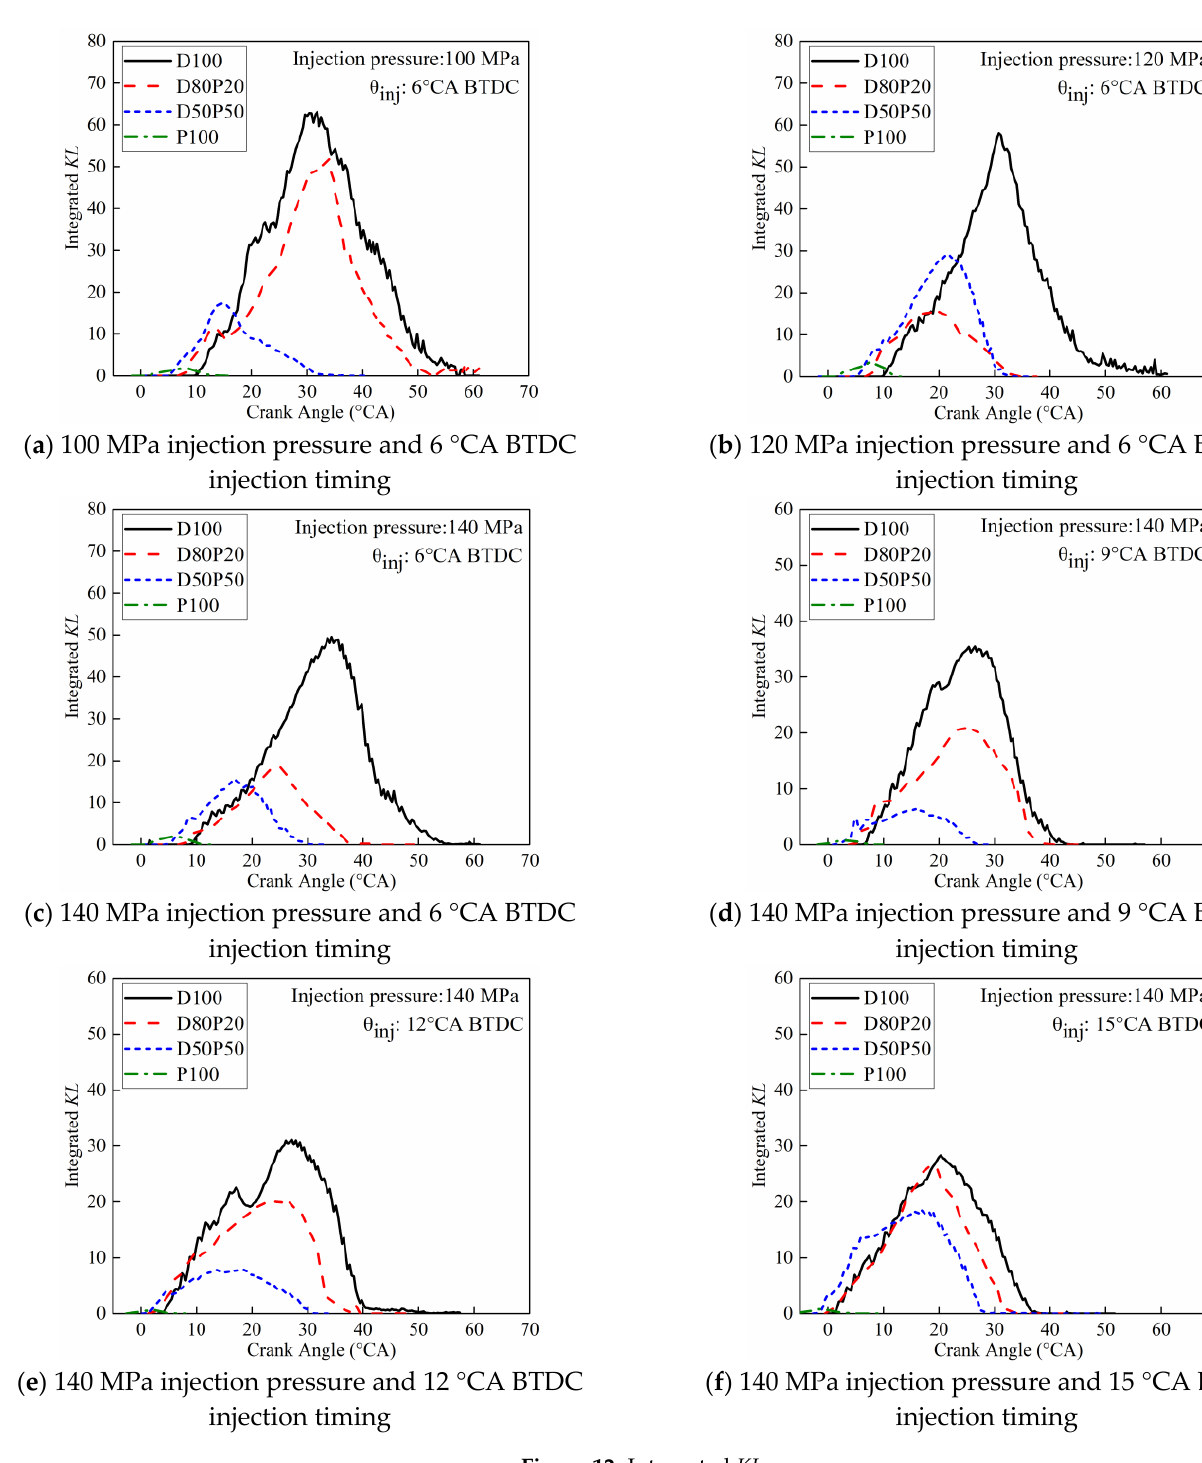
Figure 12. Integrated KL .